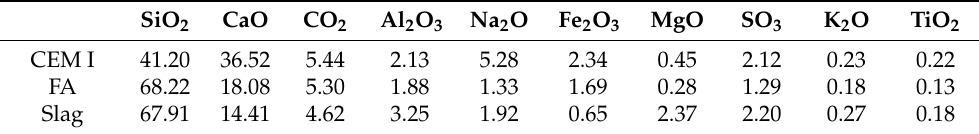
Table 3. Chemical composition of the